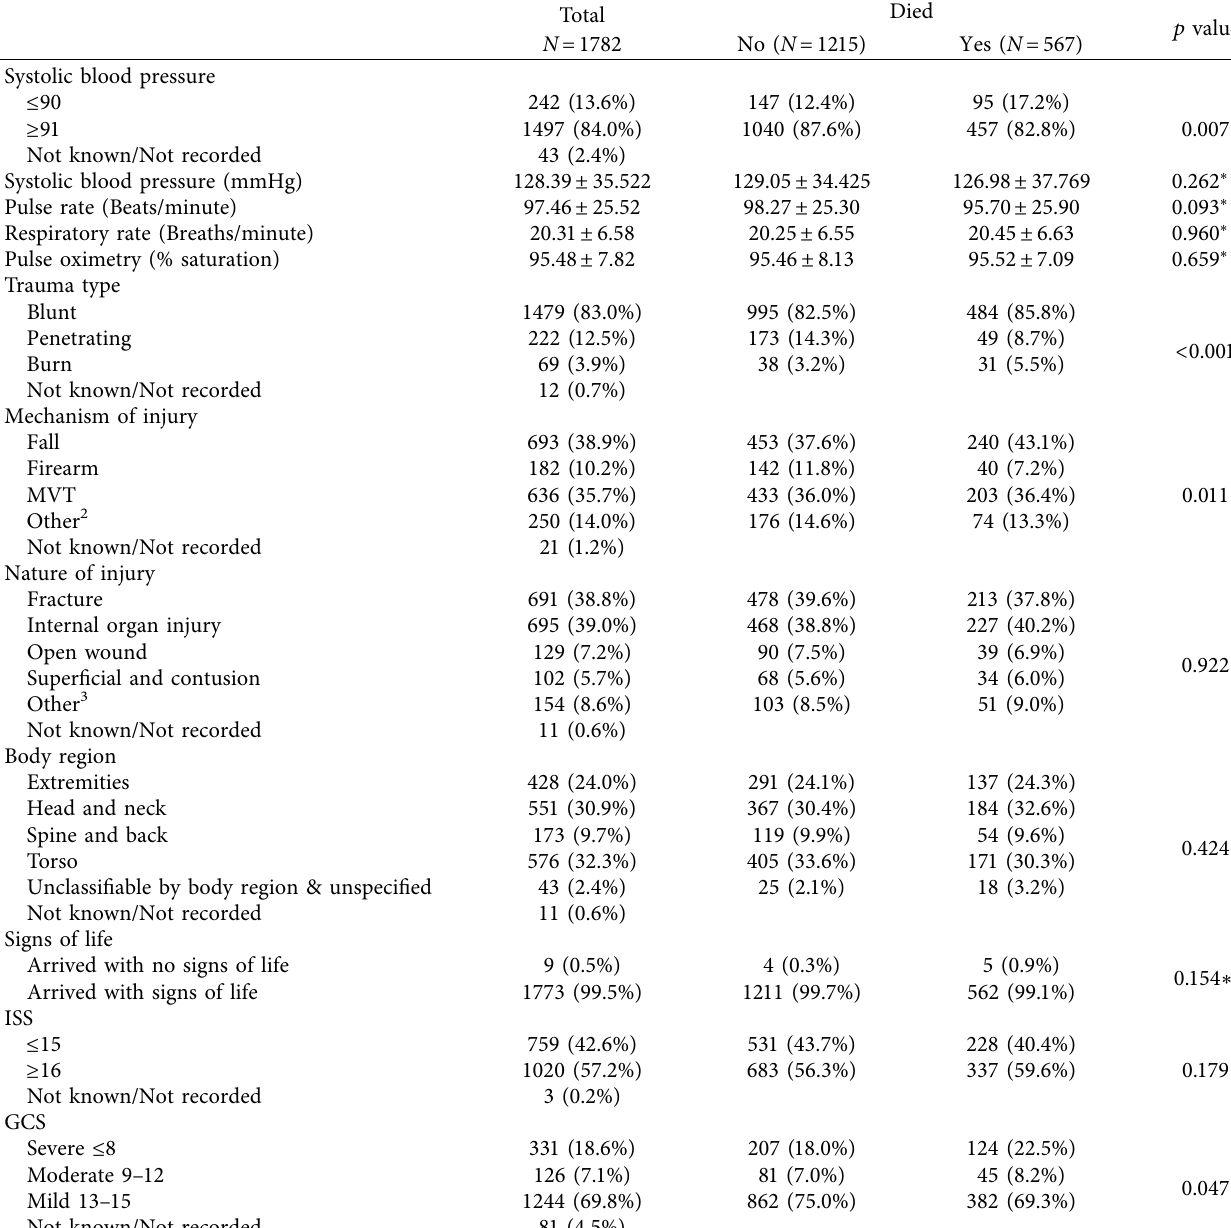
Table 2: Table showing the baseline vital signs, trauma characteristics, and state of presentation of trauma patients who developed sepsis during their hospital